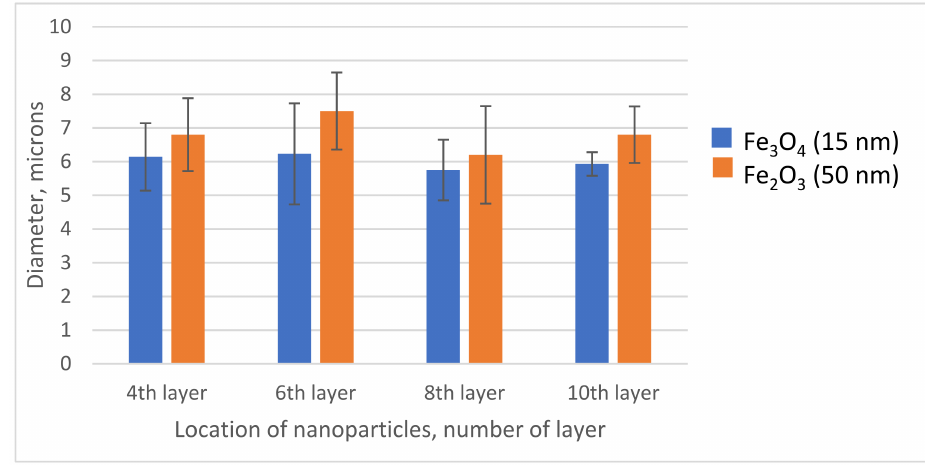
Figure 2. Mean diameter of microcapsules.